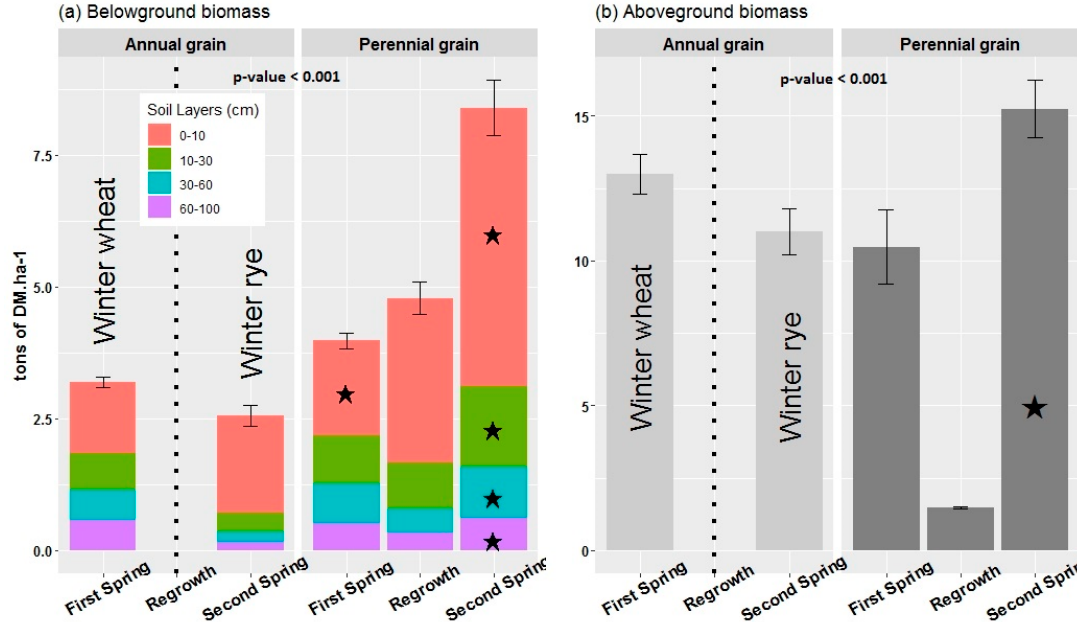
Figure 2. Mean root dry biomass ( a ) and aboveground dry biomass ( b ) measured under annual and perennials grains during two crop seasons. Statistical differences (post hoc analyses) between annual and perennial grains are indicated by ★ . Error bars indicate standard errors, from 0 to 100 cm depth.